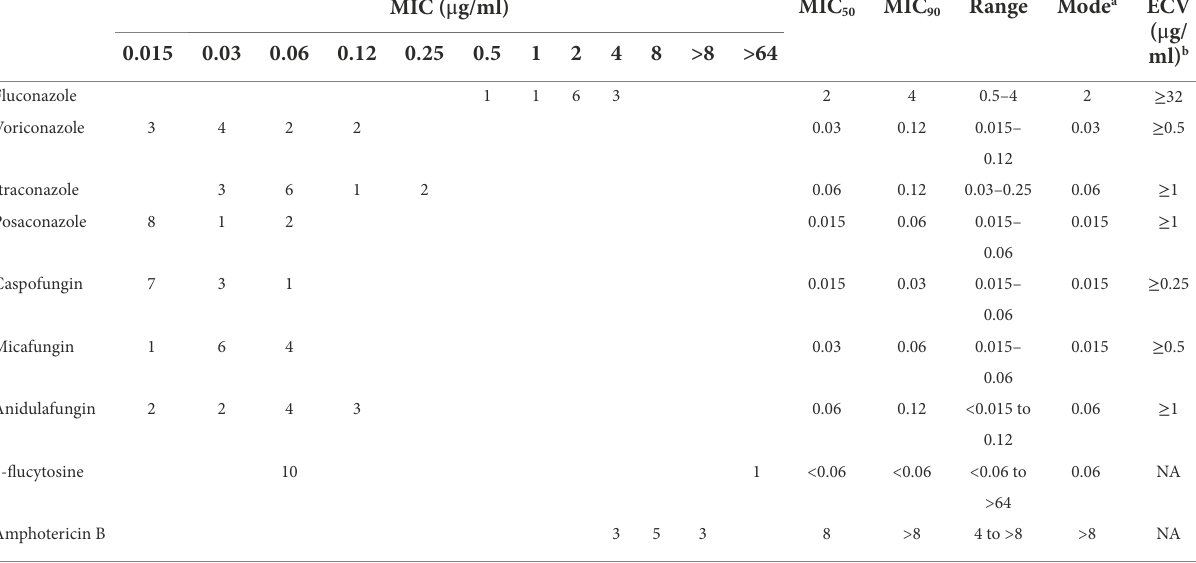
TABLE 2 Epidemiological cutoff values (ECV) of nine antifungal agents based on aggregated minimum inhibitory concentration distributions for C . duobushaemulonii